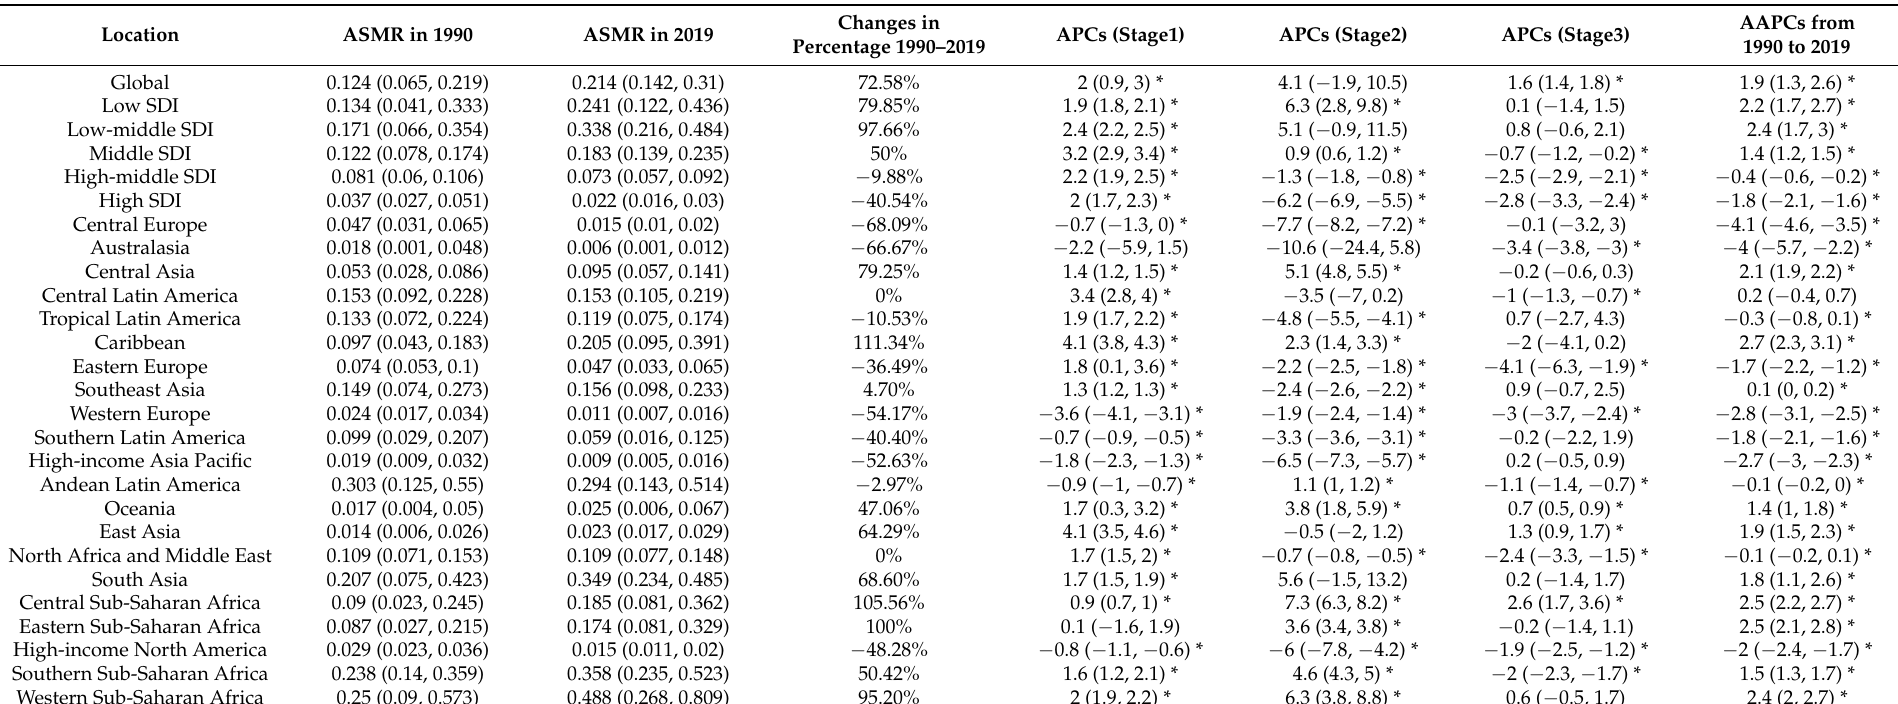
Table 1. Age-standardized mortality rate in 1990 and 2019: changes in percentage, annual percentage changes, and average annual percentage changes in PM2.5-related neonatal infections from 1990 to 2019 globally and in different